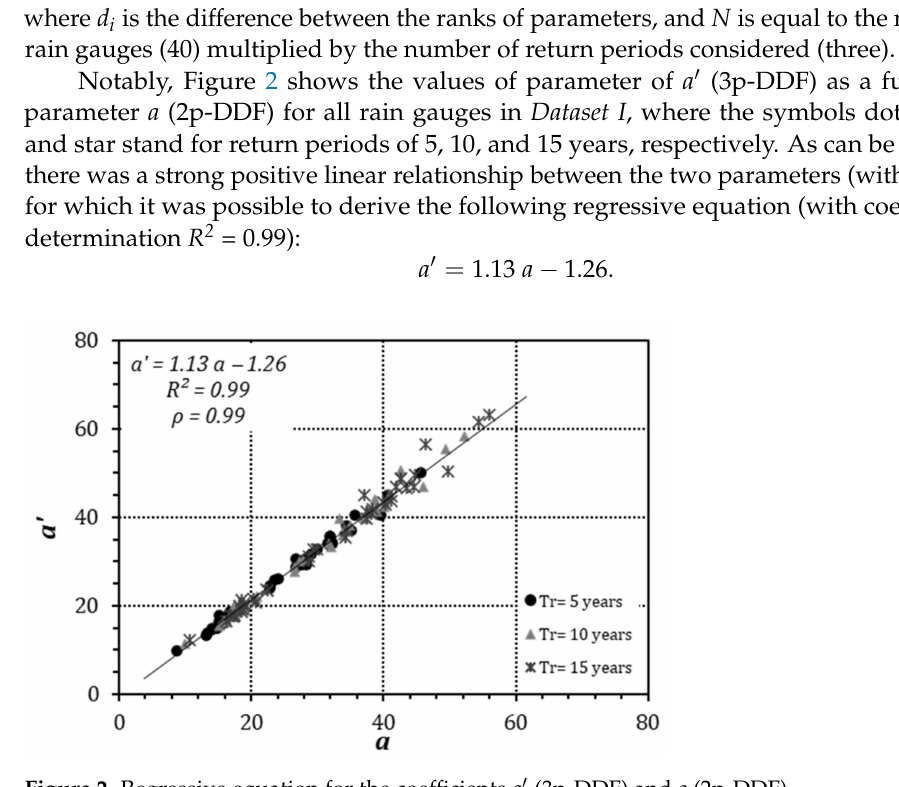
Figure 2. Regressive equation for the coefficients a (cid:48) (3p-DDF) and a